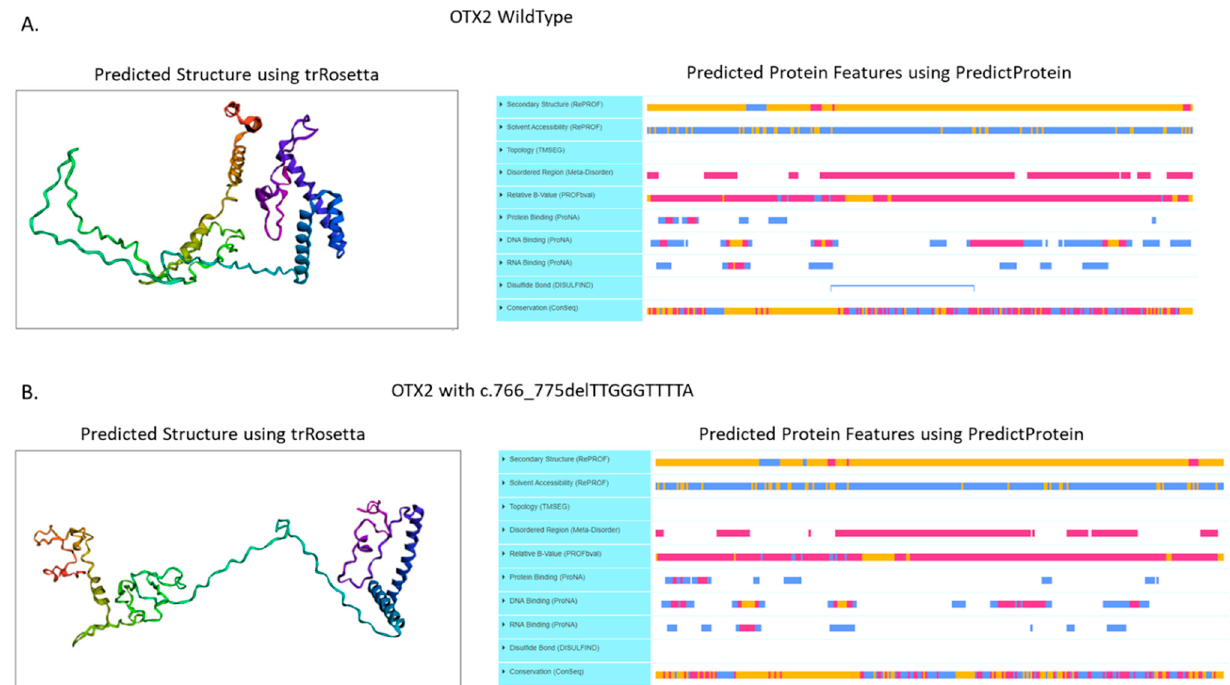
Figure 5. ( A ) Predicted structure and protein features of the wild type OTX2 protein. ( B ) Predicted structure and protein features of the frameshift variant Leu256ThrfsTer43 on the OTX2 protein. Predicted structure was obtained using the trRosetta tool (https://yanglab.nankai.edu.cn/trRosetta/ access on 15 November 2022), instead the predicted protein features were calculated using the PredictProtein tool (https://predictprotein.org/ access on 15 November 2022).